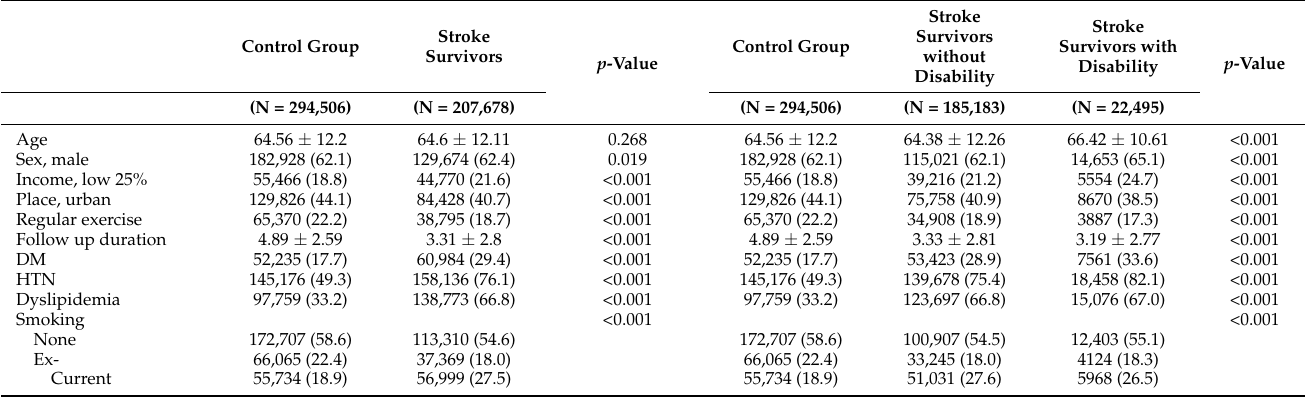
Table 1. Baseline characteristics of study